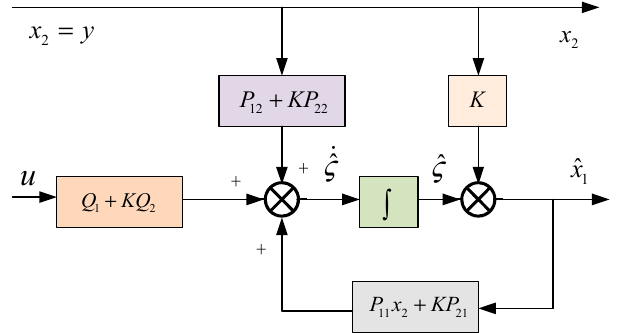
Figure 2. The structure diagram of the reduced-order flux observer for EESM. Combined with the simulation parameters of the electrically excited synchronous The design of feedback matrix K requires comprehensive consideration of the rapidity motor, the pole distribution of the motor below the rated speed designed by the reduced- and stability of the system. Equation (18) gives the characteristic equation of the system. order observer method can be made and shown in Figure 3: To satisfy the stability requirements, the eigenvalues of ( P 11 + KP 21 ) need to be completely in the left half-plane of the s plane. Moreover, the more left the eigenvalues of ( P 11 + KP 21 ) are, the faster the system is. The stability of ( Q 1 + KQ 2 ) is